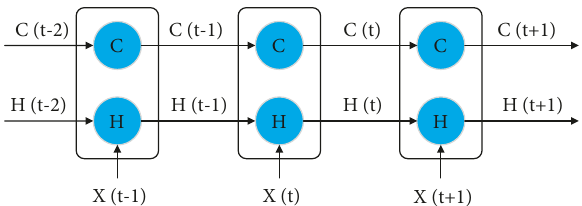
Figure 4: LSTM network expansion diagram by time